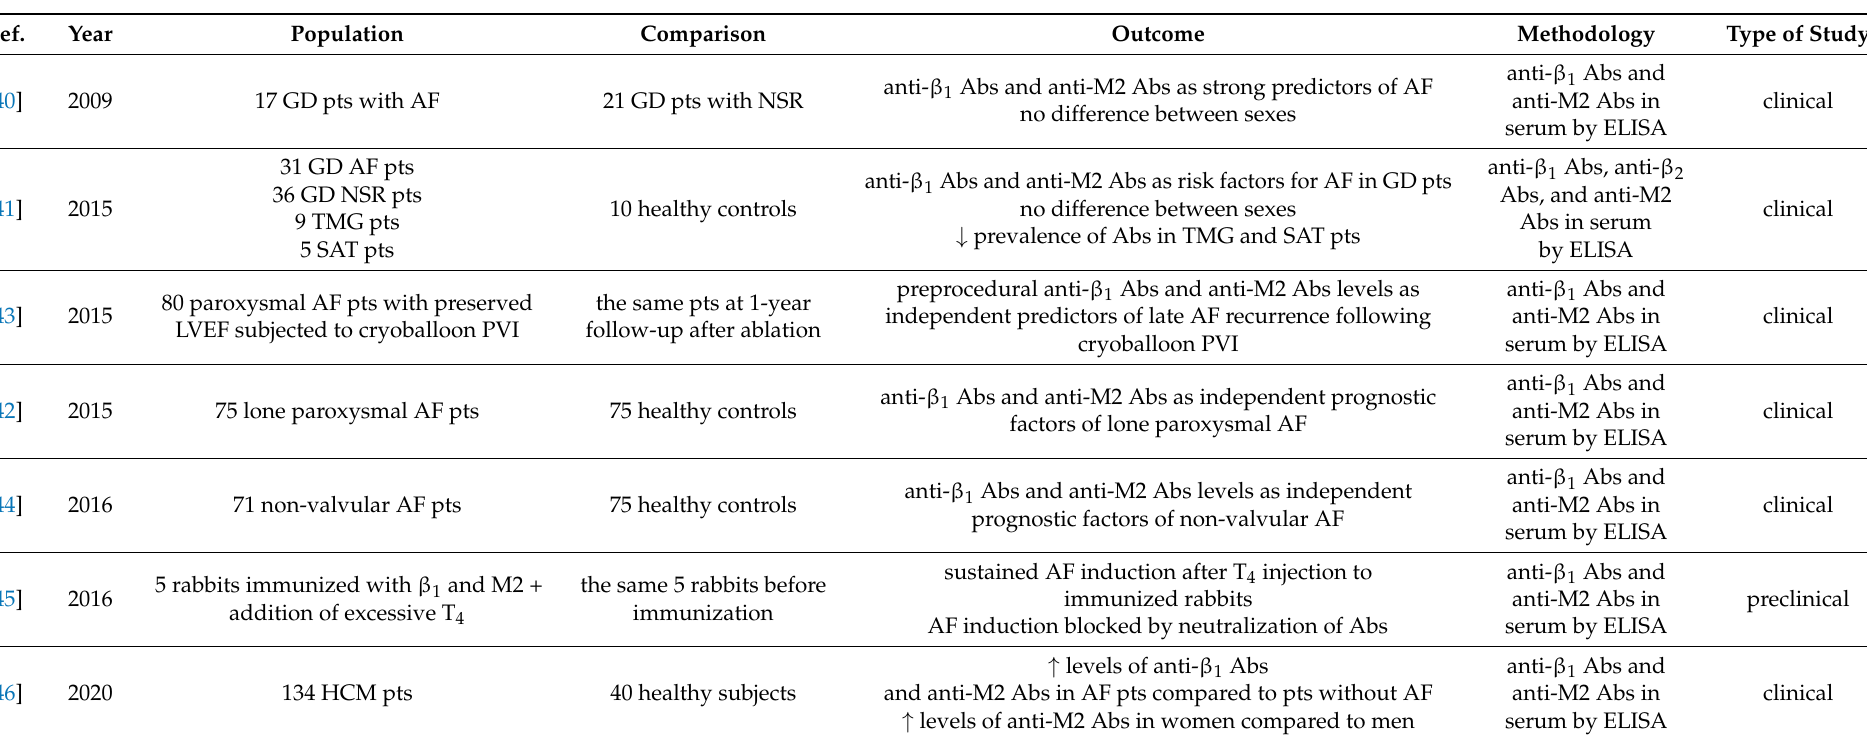
Table 3. Summary of recent research investigating both antibodies against β -adrenergic receptors and antibodies against M2-muscarinic acetylcholine receptor.